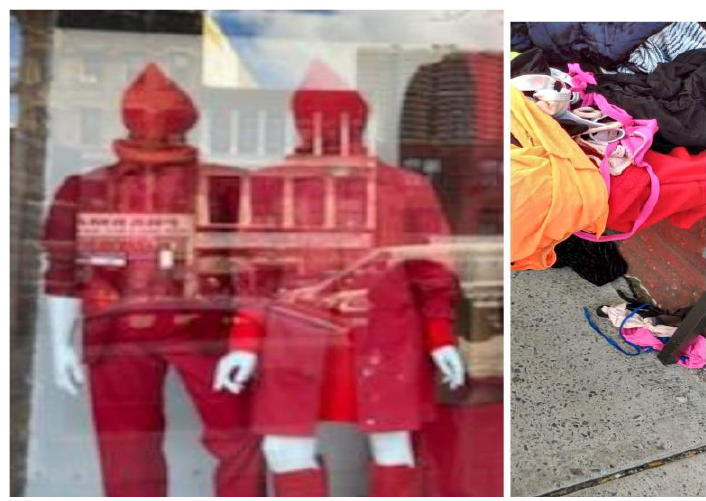
Figure 8. Lack of access to professional attire.